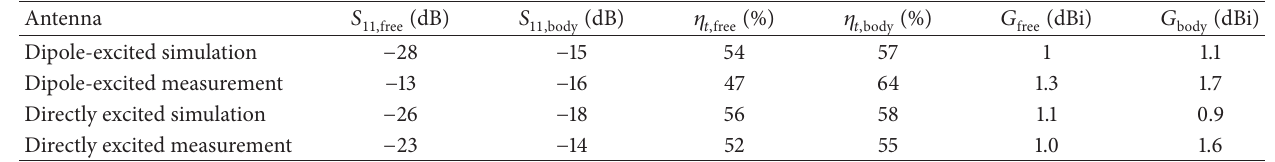
Table 1: Simulated and measured electrical parameters of coupled-patch antennas.